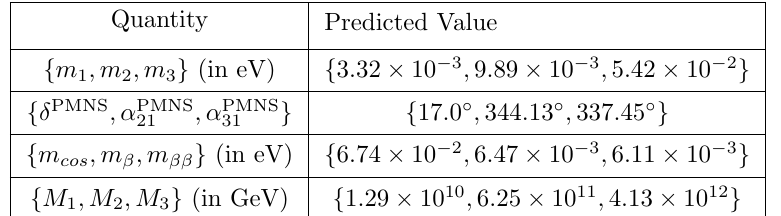
Table 3 . Predictions corresponding to the best (cid:12)t values presented in table 2 for type-I dominance seesaw scenario. m i are the light neutrino masses, M i are the right handed neutrino masses, (cid:11) 21 ; 31 are the Majorana phases following the PDG parametrization, m cos = P the e(cid:11)ective mass parameter for beta-decay and m (cid:12)(cid:12) = for neutrinoless double beta decay.